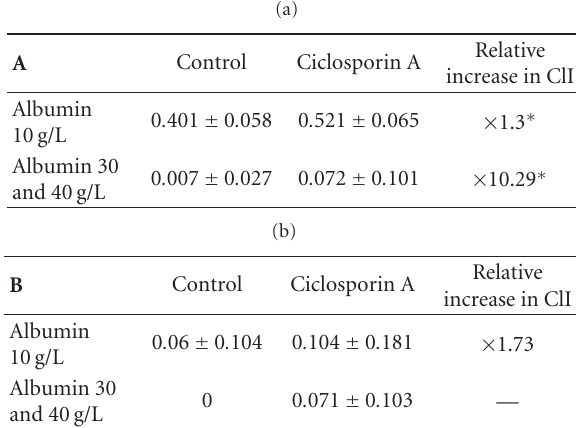
Table 1: Clearance index of lopinavir (A) and ritonavir (B) combination at steady state. (mean ± SD). ∗ means P ≤ .